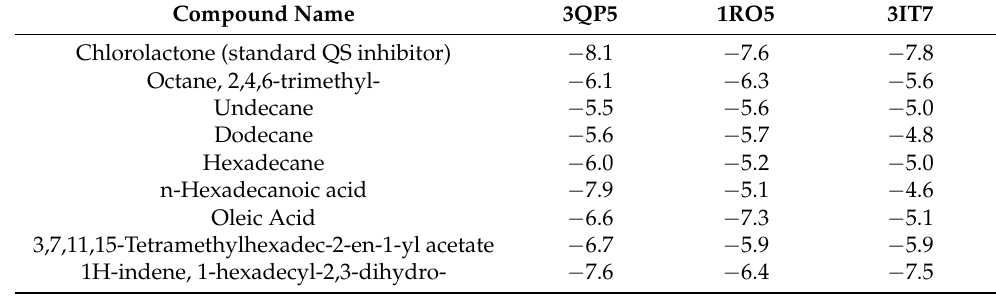
Table 3. Binding affinities of the top-rated pose of the ligand – receptor complex.